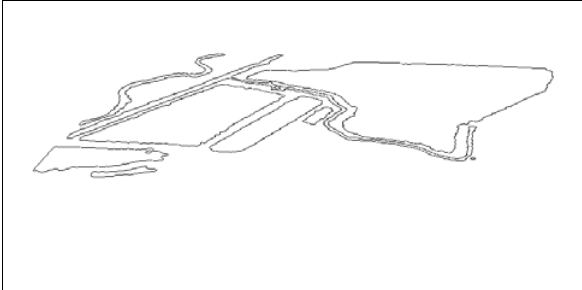
Figure 10. 3D break lines for water bodies shown in figure 9